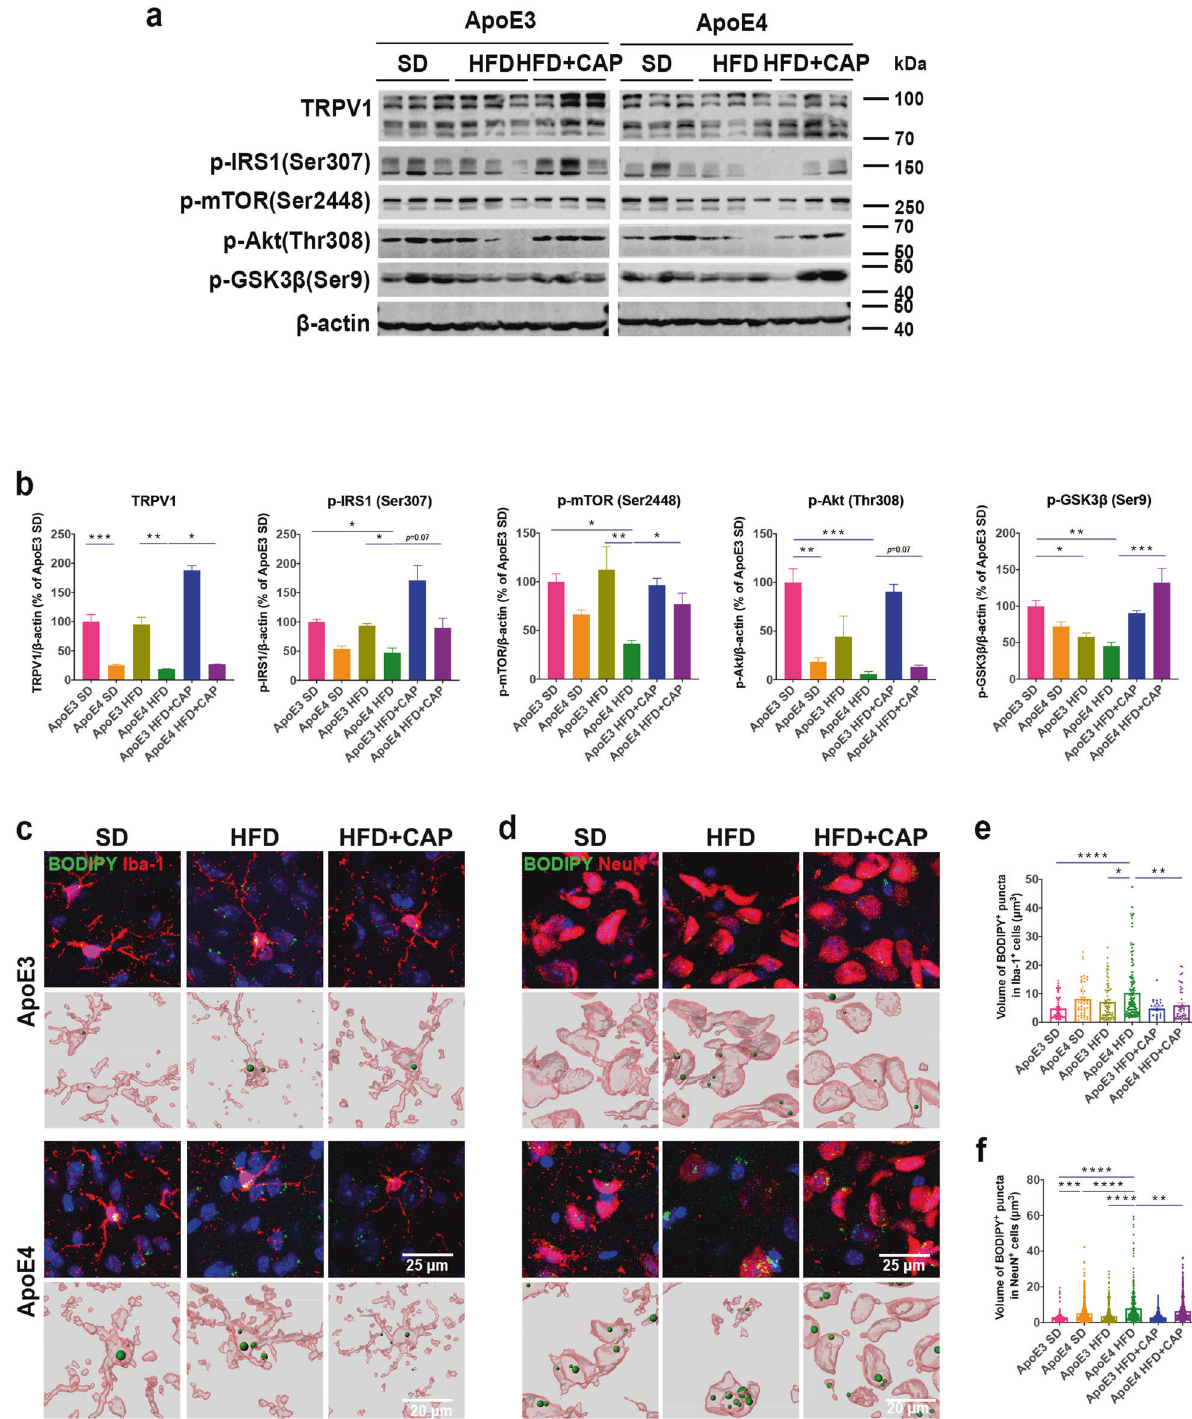
Fig. 5 TRPV1 activation reversed lipid droplet accumulation in ApoE4 HFD mice. a , b Western blot and quanti fi cation of TRPV1, p-IRS1 (Ser307), p-mTOR (Ser2448), p-Akt (Thr308), and p-GSK3 β (Ser9) levels. c , d Immuno fl uorescent images in the upper panel show cortical sections of ApoE3 and ApoE4 mice costained for BODIPY + Iba-1 + ( c ) or BODIPY + NeuN + ( d ) cells. The lower panel shows 3D reconstructions of BODIPY + Iba-1 + or BODIPY + NeuN + cells. e , f Quanti fi cation of BODIPY + Iba-1 + or BODIPY + NeuN + cell percentages in the cerebral cortex. n = 3 mice per group ( a , c , d ). Statistical tests: one-way ANOVA followed by Tukey ’ s post hoc test ( b , e , f ). Data represent the mean ± s.e.m. ( b , e , f ). * p < 0.05, ** p < 0.01, *** p < 0.001, **** p < 0.0001. ns, not signi fi cant. Scale bars, 25 μ m (upper panel), 20 μ m (lower of microglial end-point junctions also showed a growth trend in models 46 – 48 . Morphometric analysis of microglia in the cerebral ApoE4 HFD mice (Fig. 6c, d). Microglia of ApoE4 HFD + capsaicin cortex revealed that the microglial branch length and the Iba-1 + mice exhibited a signi fi cantly more activated state than those of cell area of ApoE4 HFD mice were signi fi cantly increased ApoE4 HFD mice, including shorter microglial branch length, compared to those of ApoE3 HFD mice (Fig. 6c, d). The number